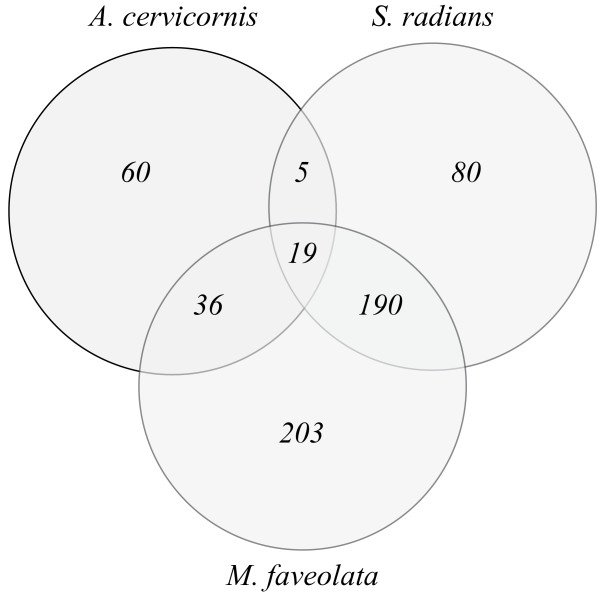
 Venn diagram of highly divergent genes shared between species.